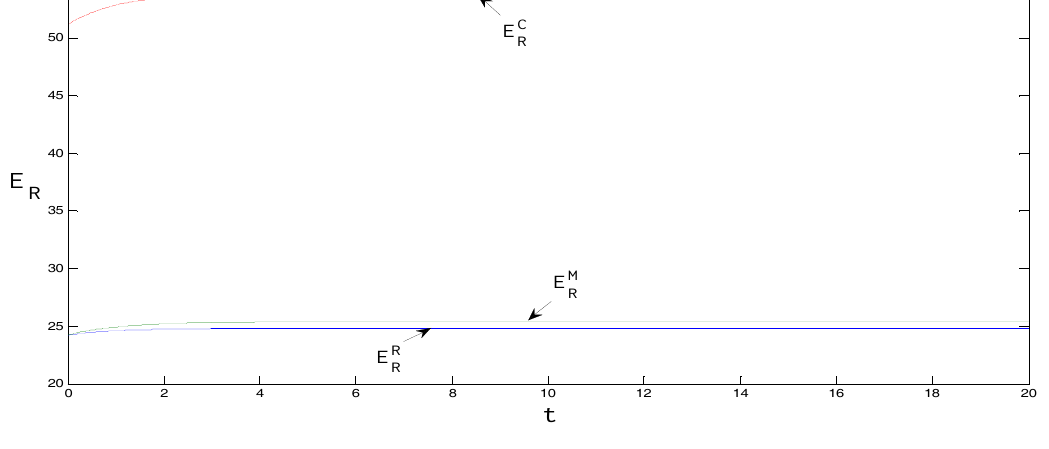
Figure 5. Comparison of emissions reduction efforts. It can be observed from Figures 4 and 5 that promotional efforts in support of low ‐ carbon products and carbon emissions reduction efforts are the largest under centralized decision ‐ making, followed by when manufacturers bear the low ‐ carbon product promotional costs, and lastly when retailers bear the promotional costs. Which party bears the low ‐ carbon product promotional costs has little impact on the promotional effort but significantly affects carbon emissions reduction efforts per product unit. This phenomenon primarily occurs because when the manufacturers bear the promotional cost of low ‐ carbon products, the level of carbon emissions reduction efforts increases, which is more conducive to the promotion of low ‐ carbon products. Therefore, when manufacturers bear the promotional costs of low ‐ carbon products, the carbon emissions reduction effort per product unit is significantly greater than when retailers bear the promotional costs. 5. Conclusions This paper constructs a derivative game model for manufacturers and retailers. We use the model to analyze the impact of emissions reduction efforts and low ‐ carbon product promotion on the supply ‐ chain carbon emissions reduction strategy under three scenarios: (1) when the low ‐ carbon product promotional cost is borne by either the manufacturers or (2) the retailers and (3) under centralized decision ‐ making in the supply chain. The main conclusions are as follows: (1) The retail price per product unit increases when manufacturers bear the promotional cost of low ‐ carbon products. However, the corresponding carbon reduction effort and promotional effort are greater than when retailers bear the promotional cost. In addition, the impact of carbon